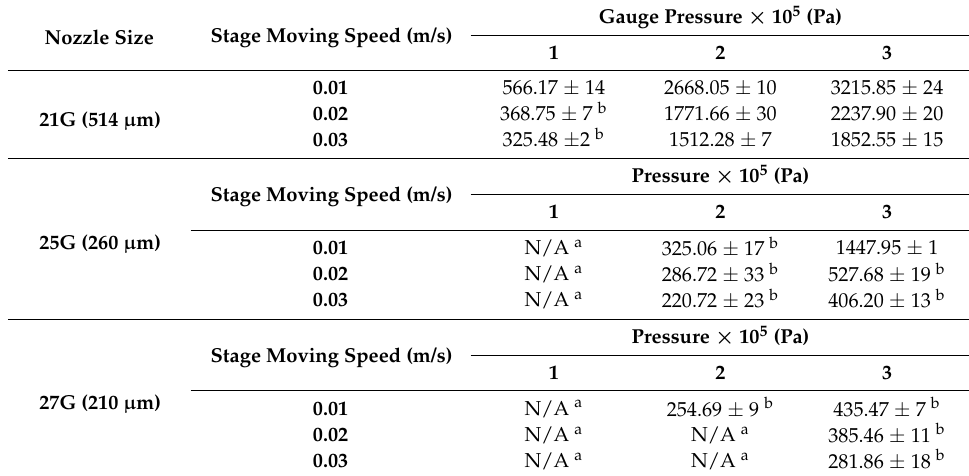
Table 2. Line width results from extrusion-based bioprinter in micrometers ( µ m). Nozzle Size